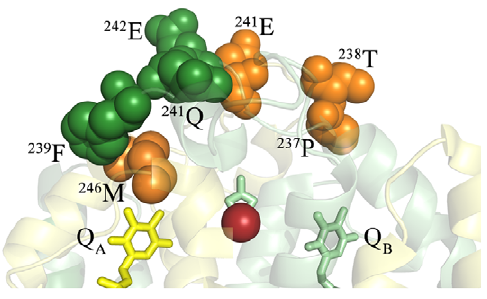
Figure 4. Detail of the Oxidized Residues in the Vicinity of Pheo D1 . The T. vulcanus residues corresponding to the oxidatively modified spinach residues (Table 1) are highlighted and labeled. The D1 protein is shown in pale green and the D2 protein is shown in pale yellow. The oxidatively modified residues of D1 are shown in dark green, with the individual modified residues being labeled. Pheo D1 is shown in bright green, Q A is shown in yellow, Q B in green and the non- heme iron is shown in bright red. For clarity, modified residues in the vicinity of Q A (and detailed in Fig. 3) are not